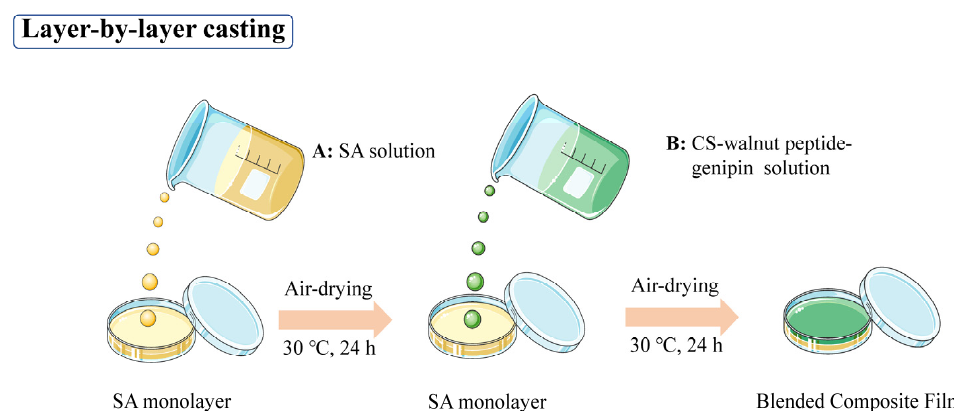
Figure 1. The preparation process of films.